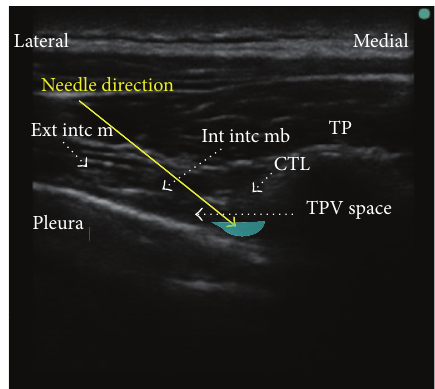
Figure 1: Thoracic paravertebral block, transverse in line technique. Needle trajectory: lateral to medial. TP = transverse process. TPV = thoracic paravertebral. Int into mb = internal intercostal membrane. Ext into m = external intercostal muscle. CTL = costotransverse